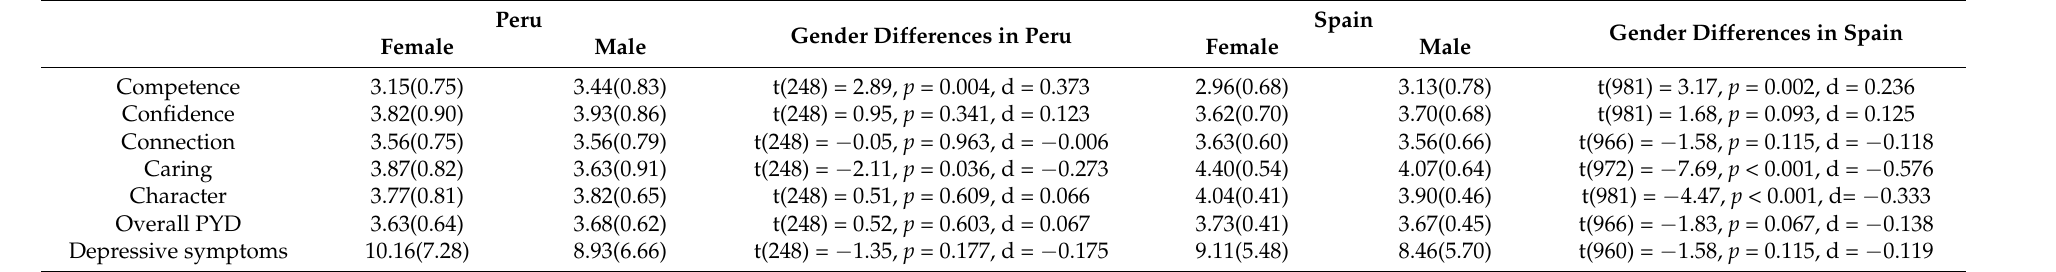
Table 2. Gender differences in the 5Cs of PYD and depressive symptoms among students in Peru and Spain, t-test analysis. Peru Gender Differences in Peru